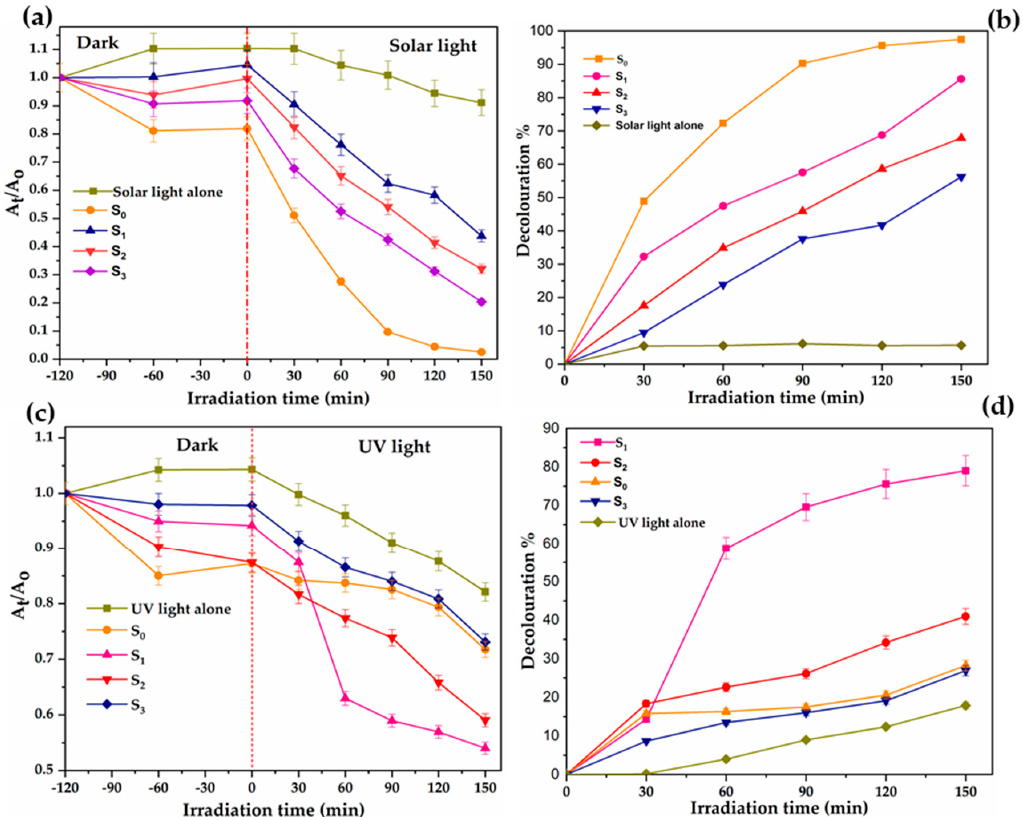
Figure 8. Photocatalytic decolouration of orange II by TiO 2 Degussa and C–N–TiO 2 Nano composites pyrolysed at 350 ◦ C under N 2 gas using 50 ◦ C / min ramping rate for di ff erent holding times (S 0 = with Degussa TiO 2; S 1 = C–N–TiO 2 105 min; S 2 = C–N–TiO 2 120 min and S 3 = C–N–TiO 2 135 min). ( a , b ) kinetics decay and decolouration e ffi ciency of O.II dye in the dark and in solar light correspondingly. ( c ) and ( d ) kinetics decay and decolouration e ffi ciency of O.II dye in the dark and in UV light, respectively. Experimental conditions O.II concentration 5 mg / L, volume 500 mL, pH 2.5, catalyst dosage 0.08 g